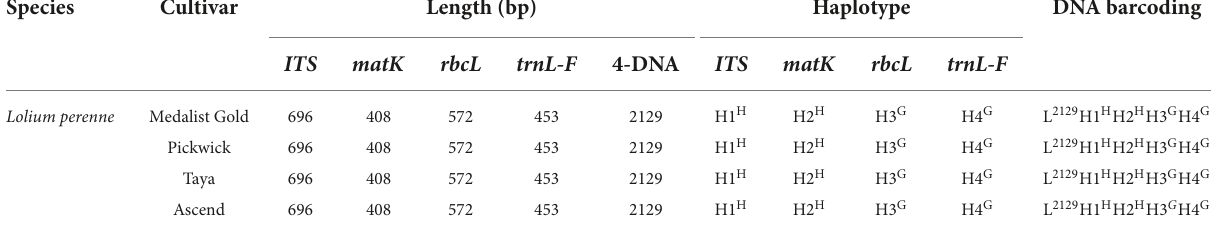
TABLE 5 Database of DNA barcoding for four varieties of Lolium